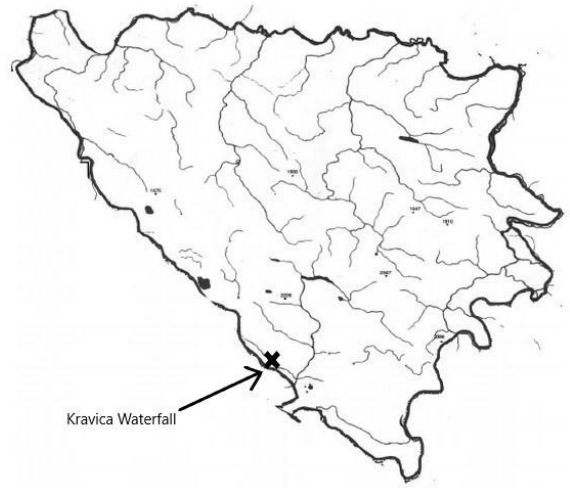
Figure 1. Location of Kravica Waterfall on the map of Bosnia and Herzegovina